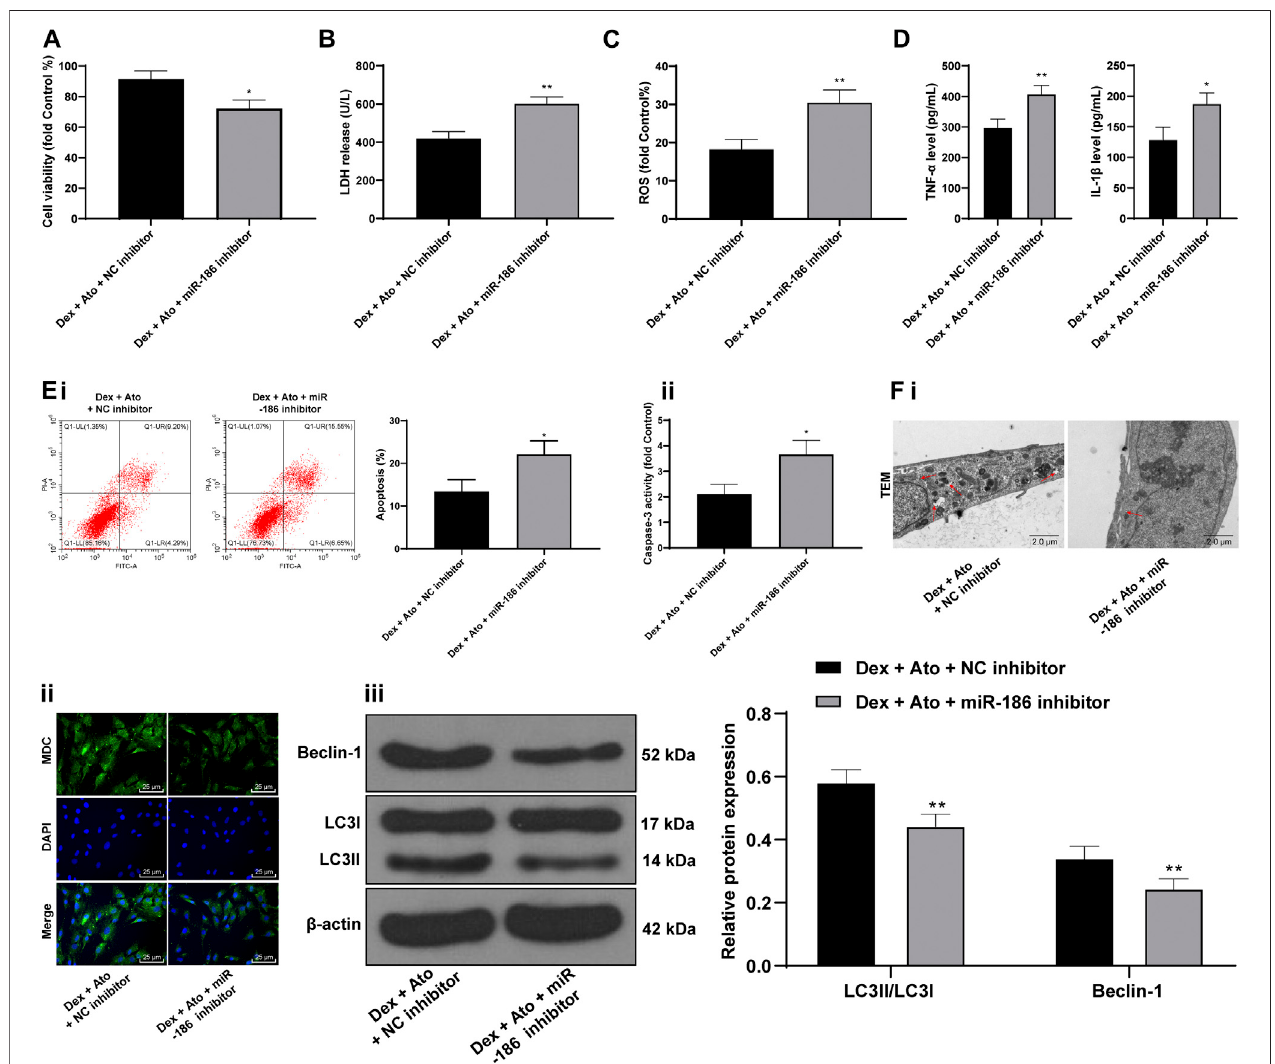
FIGURE 6 | Ato relieves DEX-induced osteoblast injury via upregulation of miR-186. DEX-pretreated OB-6 cells were selected to simulate the in vitro model of SANFH, then treated with 0.1 μ M Ato and transfected with miR-186 inhibitor, and the cell damage and autophagy were observed. (A) MTT assay detected OB-6 cell viability; (B) Relative LDH release in OB-6 cells was analyzed by an LDH assay kit; (C) ROS level in OB-6 cells was measured by DCFH-DA probe; (D) levels of in fl ammatorycytokines(TNF- α andIL-1 β )weredetectedbyELISAkits; (E) apoptosisoffemoralheadwasdetectedby fl owcytometry (i) andcaspase-3activitytest (ii) ; (F) transmission electron microscopy (i) and MDC fl uorescence staining (ii) were used to observe autophagy; (iii) , western blot analysis was used to detect LC3II/ LC3I and Beclin-1 expression. Replicates (cid:1) 3. The data are shown in mean ± standard deviation. * p < 0.05, ** p < 0.01, vs. the control group; # p < 0.05, ## p < 0.01 vs. DEX